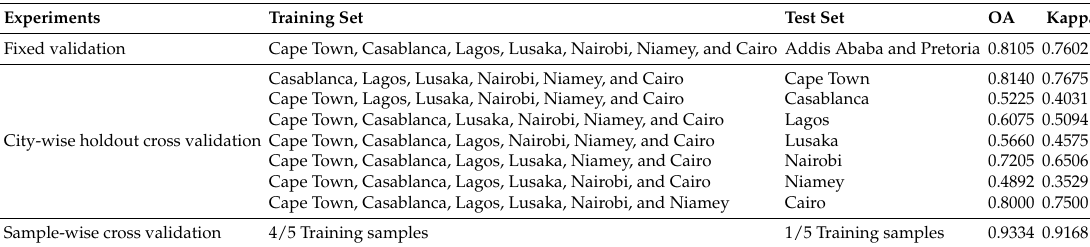
Table 5. Accuracy indexes of transferablity evaluation experiments.